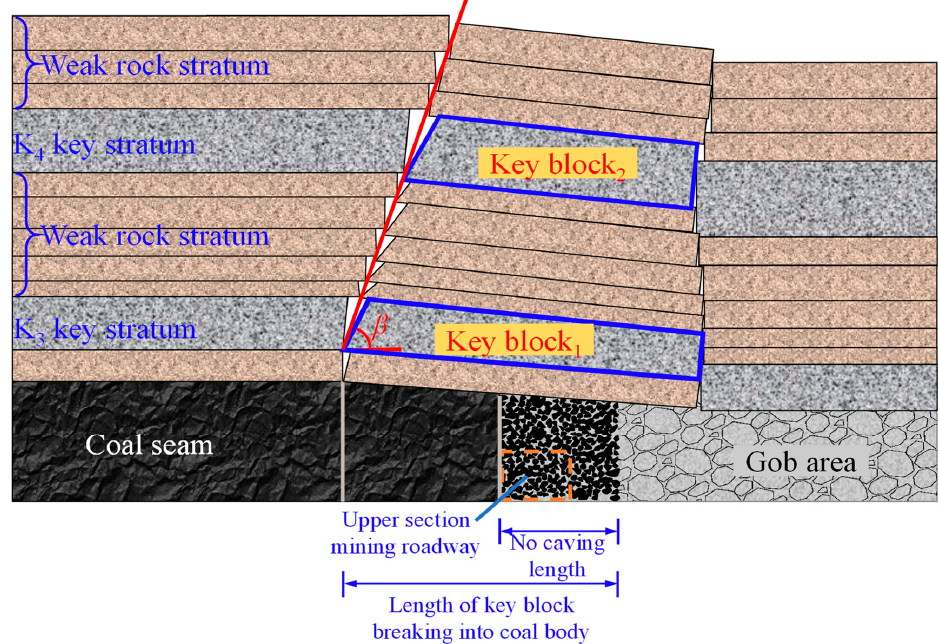
Figure 8. Fracture morphology of key blocks [48].